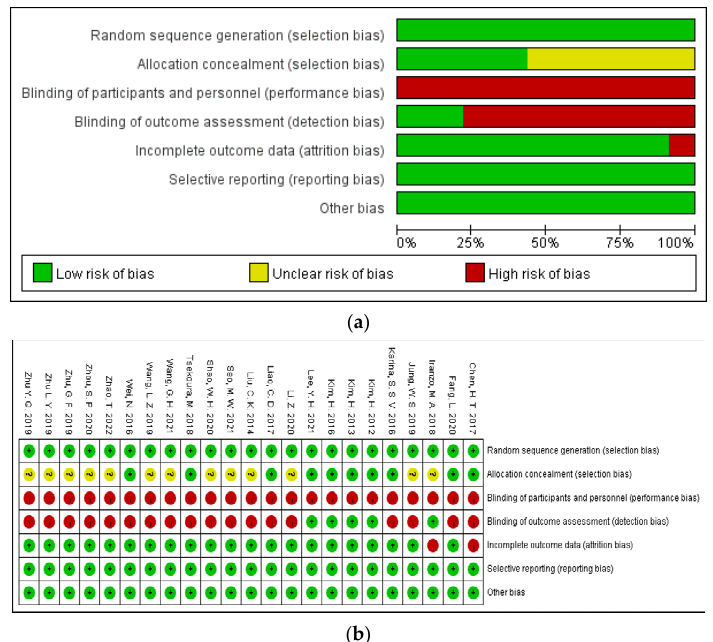
Figure 2. ( a ) The weighted plot for the assessment of the overall risk of bias; ( b ) summary of the bias for the trials included in this meta-analysis. Green indicates low risk of bias, yellow indicates un- clear, and red indicates high risk of bias.